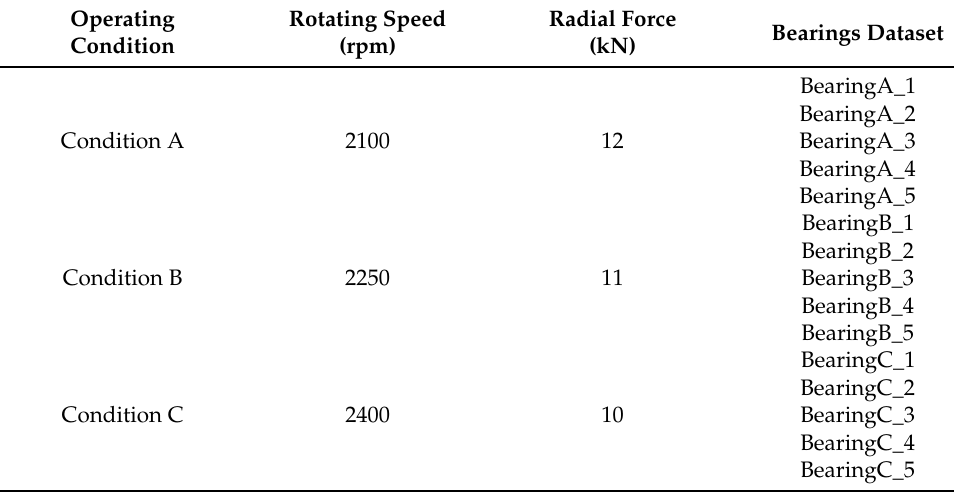
Figure 5. Bearing testbed. Table 1. Operating Conditions of the Tested